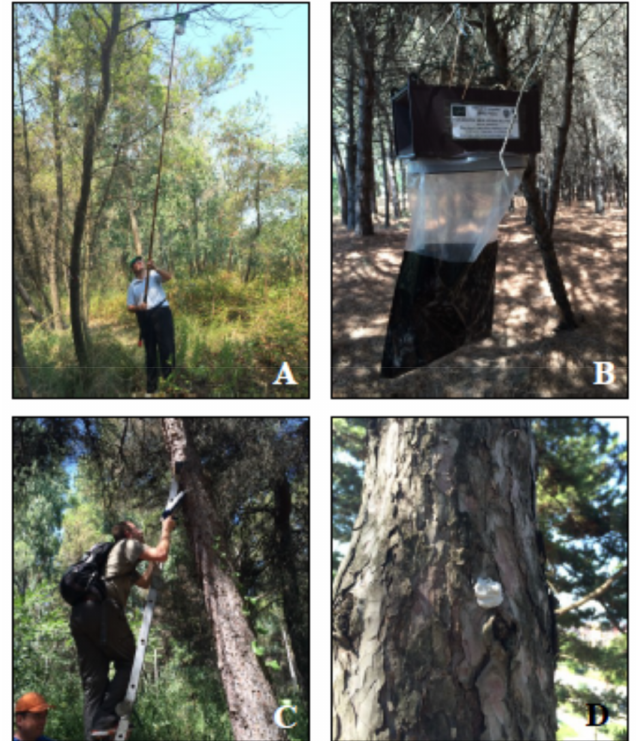
Figure 5. Control of processionary pine moths: positioning of pheromone trap in canopy of trees for monitoring and mass trapping tests ( A – B ) and application of pheromone paste on trunk and branch of trees for mating disruption trials ( C – D